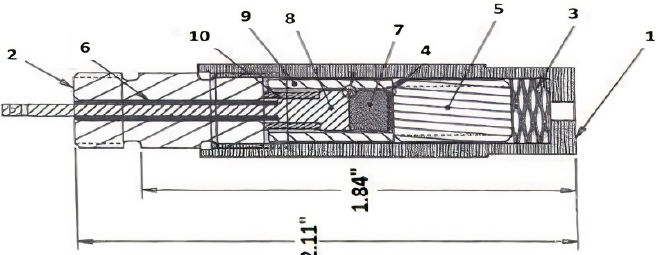
Figure 7. Sketch of the transducer capsule consisting of an outer casing ( 1 ), a cap ( 2 ), a high-temperature spring ( 3 ), the bismuth titanate wafer ( 4 ), the Kovar cylinder ( 5 ), the coaxial connection ( 6 ), the C/C backing material ( 7 ), the pressure plunger ( 8 ), and insulation ( 6 , 9 , 10 ). The bismuth titanate wafer was placed between the backing and the Kovar cylinder using foil [14].